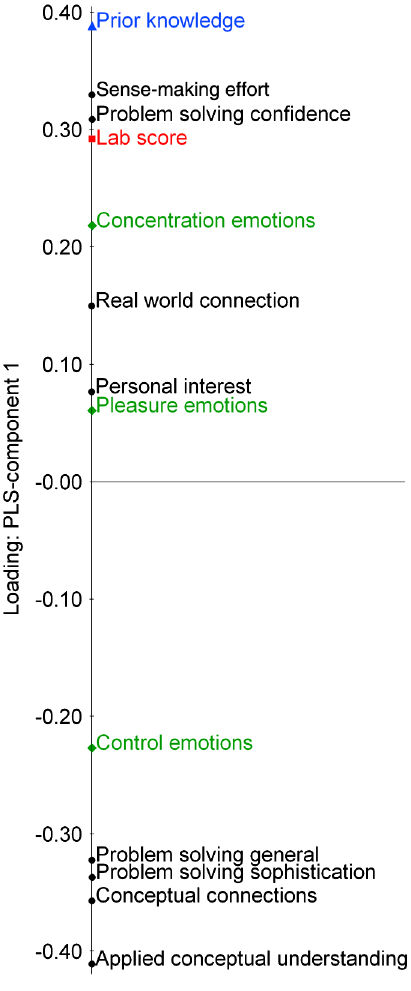
FIG. 1 (color online). PLS top model with one significant component ( y axis) showing internal correlation between con- structs as well as their relative importance for the models ability to predict the outcome variable lab score . Constructs that are close are positively correlated and those that are on the opposite side of the y axis are negatively correlated. Constructs may contain positively as well as negatively polarized test items.